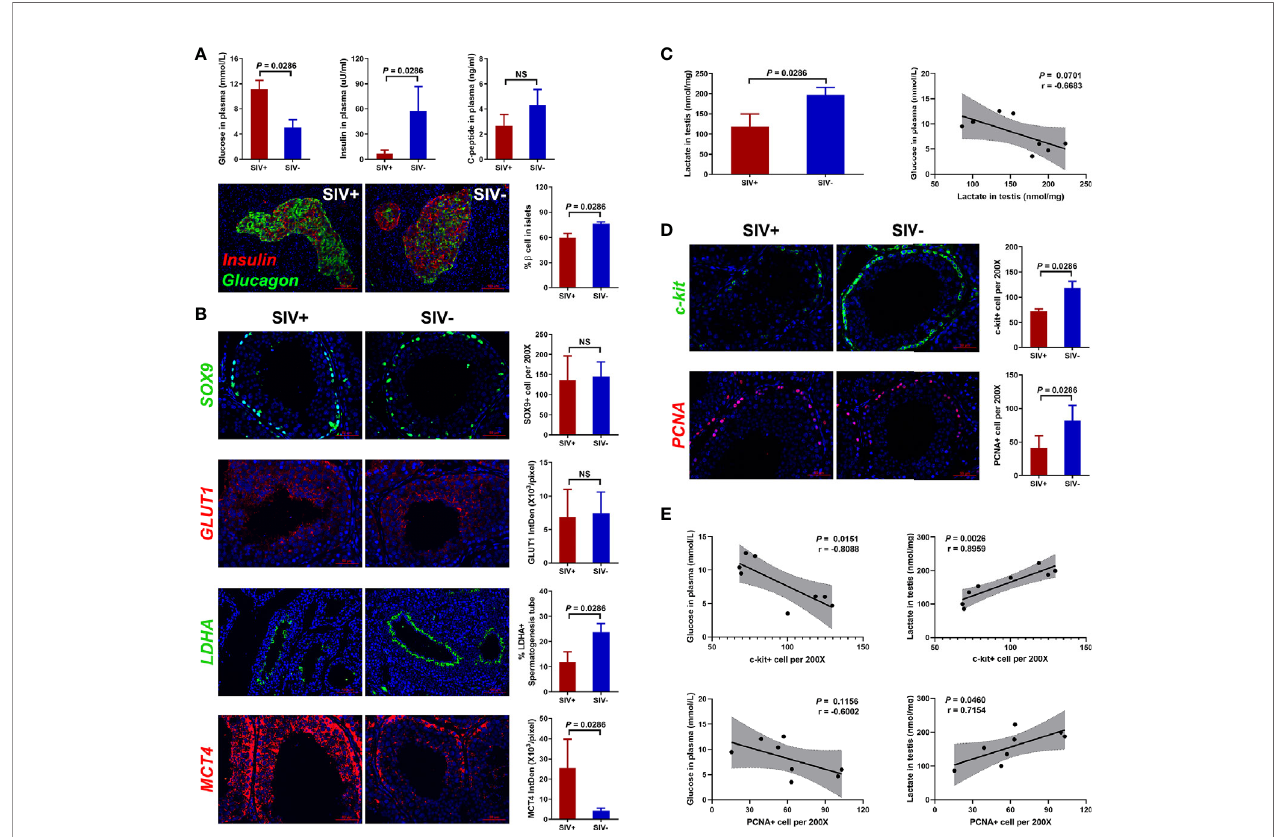
FIGURE 3 | Glucose metabolism disorder and related testicular changes. (A) Concentrations of glucose, insulin, and c-peptide in plasma, and immunological staining of insulin and glucagon in pancreatic islets; (B) Glucose metabolism analysis of Sertoli cells in testicular tissues; (C) Lactate level in testicular tissues; (D) Immunological staining of c-kit and PCNA in testicular tissues; (E) Correlation analysis of c-kit+/PCNA+ cells with glucose in plasma and lactate in testes. NS, no statistic signi fi